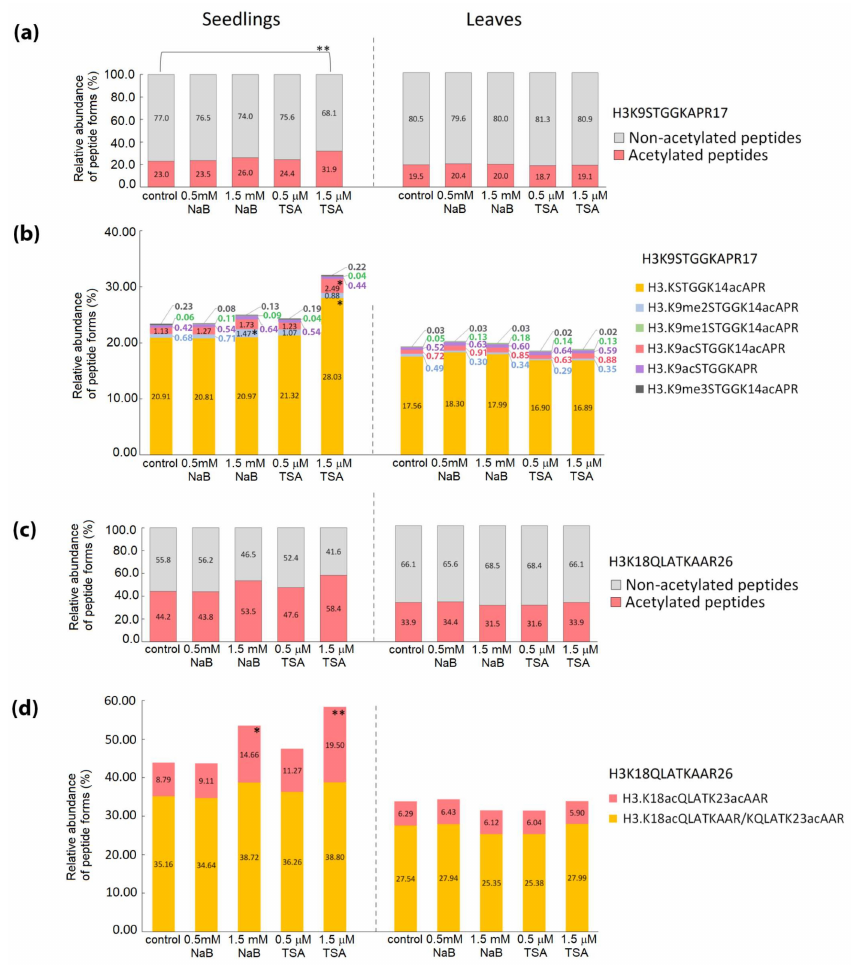
Figure 4. Relative abundance of peptide forms of histone H3 in seedlings germinated in the presence of HDA inhibitors, leaves of plants cultivated from these seedlings, and respective control samples. ( a , c ) The relative abundance of all peptide forms containing acetyl group(s) compared with that of peptides without acetylation. ( b , d ) The relative abundance of particular peptide forms containing acetyl group(s) compared with that of all other forms of respective peptide sequences. The levels of peptide forms were determined from the extracted ion chromatograms (XIC) peak areas. The significance of between-sample di ff erences was assessed using t-tests, setting the significance threshold at ** p < 0.01 and * p <